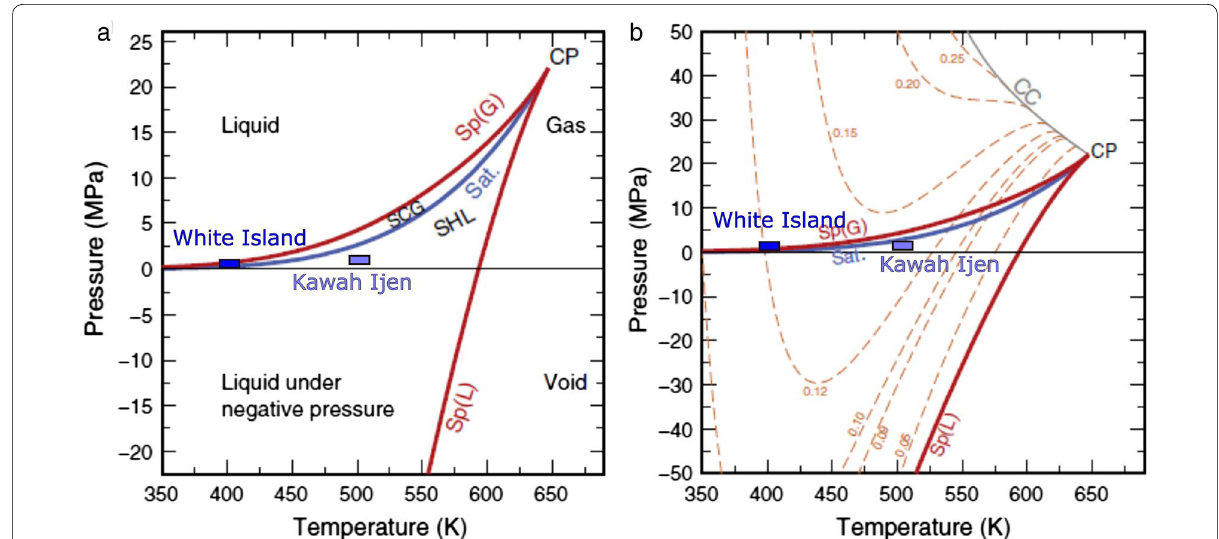
Fig. 10 Phase diagrams Stable, metastable, and unstable regions in P-T space according to IAPWS-95 equation of state of water (Wagner and Pruß 2002). In a and b the blue line is the vapor-pressure curve or saturation curve (Sat.) while the red line are the spinodals. Sp(G) is the gas spinodal, Sp(L) is the liquid spinodal. The three lines meet at a critical point (CP). SCG denotes supercooled gas, while SHL denotes superheated liquid. In b the orange dashed curves represent the liquid spinodals for the H 2 O–CO 2 critical curve (CC). The light and dark blue rectangles correspond to P-T conditions beneath the presumed seal regions at Kawah Ijen (Caudron et al. 2015b) and White Island (Christenson et al. 2017), respectively. After Thiéry and Mercury (2009a), Thiéry and Mercury (2009b) and modified from Matoza and Chouet (2010), Chouet and Matoza